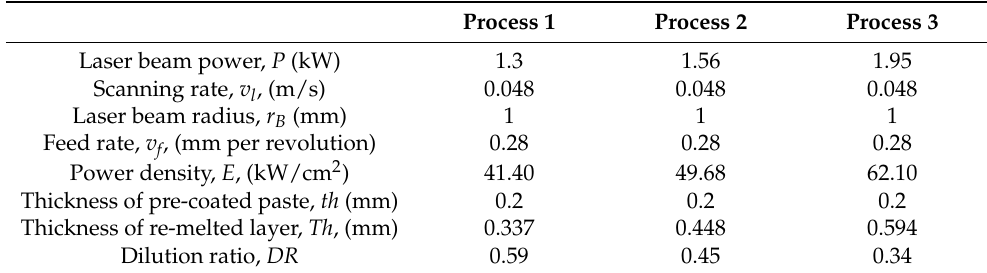
Table 2. Parameters used during laser boriding of Nimonic 80A alloy.